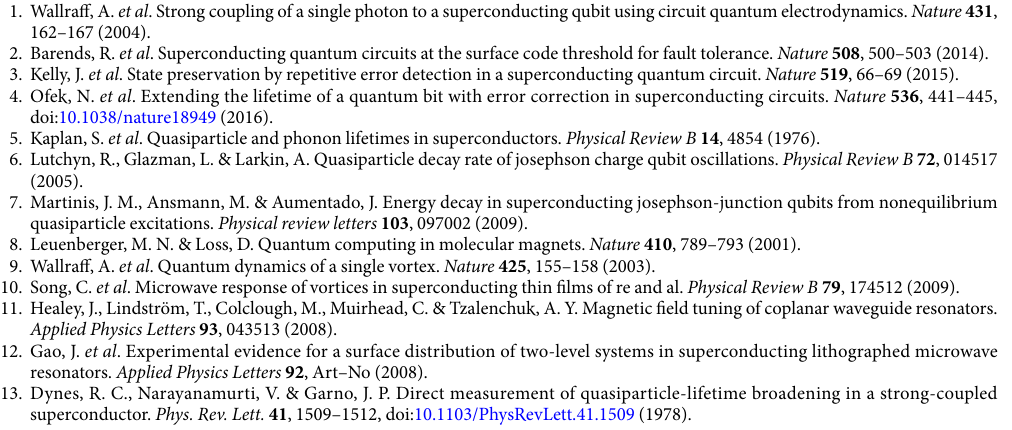
back side of the wafer was coated with 50 nm pure Nb as the ground plane of the superconducting transmission line resonators. Pure Nb, deposited at room temperature without pre- and post-annealing, was chosen as the ground plane to avoid heating damage to the materials already present on the front side. The samples were depos- ited in a reactive magnetron sputtering system (AJA International, USA) with the base pressure of 1 × 10 − 8 Torr. The substrates were first Ar-sputter cleaned for 5 minutes under substrate bias with 50 W RF power, 5 milli-Torr chamber pressure and 30 sccm of Argon flow. Then they were annealed at 700 °C for 1 hour and cooled to room temperature before the actual film growth starts. X-ray diffraction (XRD) was used to study the crystal structures of the composite films grown on the c-cut sapphire. The measurement was carried out using a Bruker D8 Discover (Bruker AXS, Germany) system with a Cu K α source. Figure 3(a) shows the high-resolution 2 θ − ω scan of the composite film. A 3-bounce monochro- mator was used in front of the source in addition to a Gobel mirror. Besides four extremely sharp peaks from the sapphire substrate, there are only peaks from Al (111) at 38.47°, Nb (110) at 38.51° and their second order diffrac- tions. Al (111) and Nb (110) are so close that they cannot be well distinguished from each other, but the Al (222) and Nb (220) clearly revealed the presence of both peaks. The appearance of only Al 111 and Nb 110 peaks indi- cate that Al and Nb are both textured. Figure 3(b) is the azimuthal XRD data (“ φ -scan”) from the Al/Nb/Al com- posite film. The upper panel is the φ -scan for Al (200) by setting ψ at 54.7° – the angle between the (111) plane and (200) plane in an fcc structure. The detection angle 2 θ was set at 44.74° which is for Al (200) reflections. Fully epitaxial Al (111) should display three-fold symmetry in the φ -scan of (200) planes. The appearance of six peaks indicates two symmetrically equivalent growth orientations (twins) occur in the Al layers, as a result of stacking three-fold symmetric fcc structures onto the six-fold symmetric hcp substrate 34 . The lower panel of Fig. 3(b) is the φ -scan for Nb (200) by setting ψ at 45°. The six-fold symmetry from Nb (200) can also be attributed to the twin growth of the bottom Al layer. We also performed 2 θ − ω scans by fixing φ at one of the off-axis peaks, such as 30° in Fig. 3(b). The Bragg diffractions confirmed the φ peaks come from 2 θ of 44.7° for Al and 55.5° for Nb, well matching the Al (200) and Nb (200) reflections. It proves that the six-fold symmetry shown in Fig. 3(b) indeed originates from the off-axis diffractions from Al (200) and Nb (200) planes.